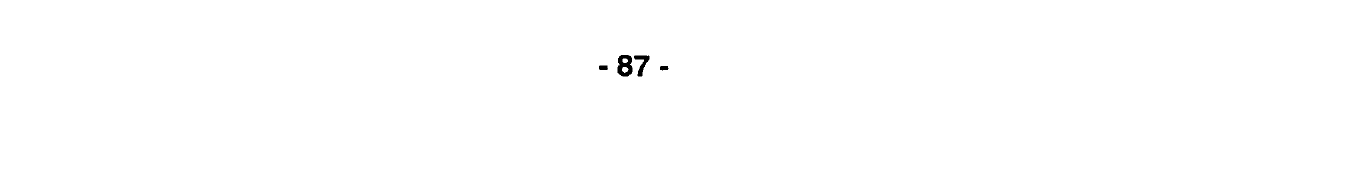
Aproksimuojant kitais lauko slopimo intervalais plysil! itaka